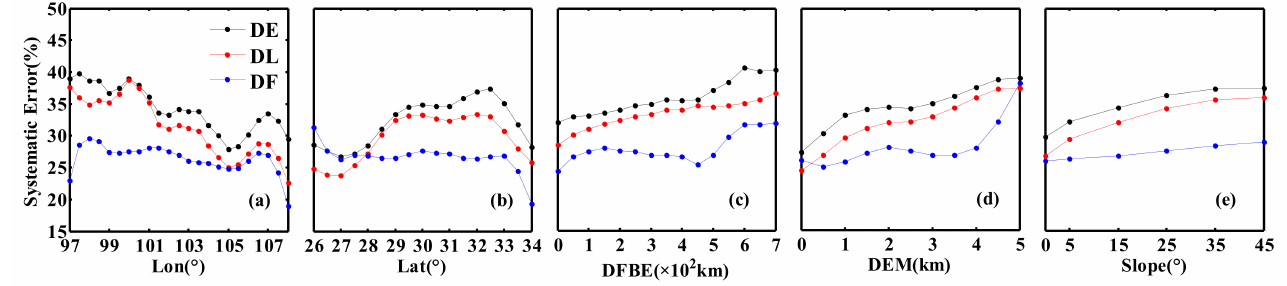
Figure 12. Relationships between systematic errors and five geographical features for three IMERG estimates. ( a – e ) represent longitude, latitude, DFBE, DEM, and Slope,